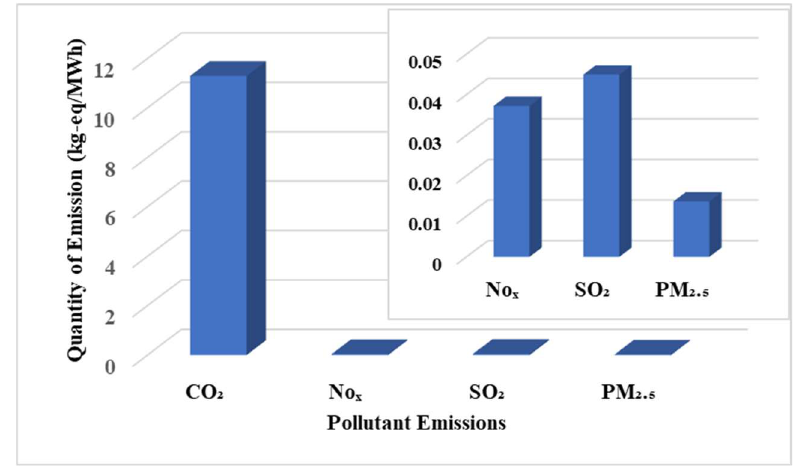
Figure 3. Different pollutant emissions from an Indian wind farm.